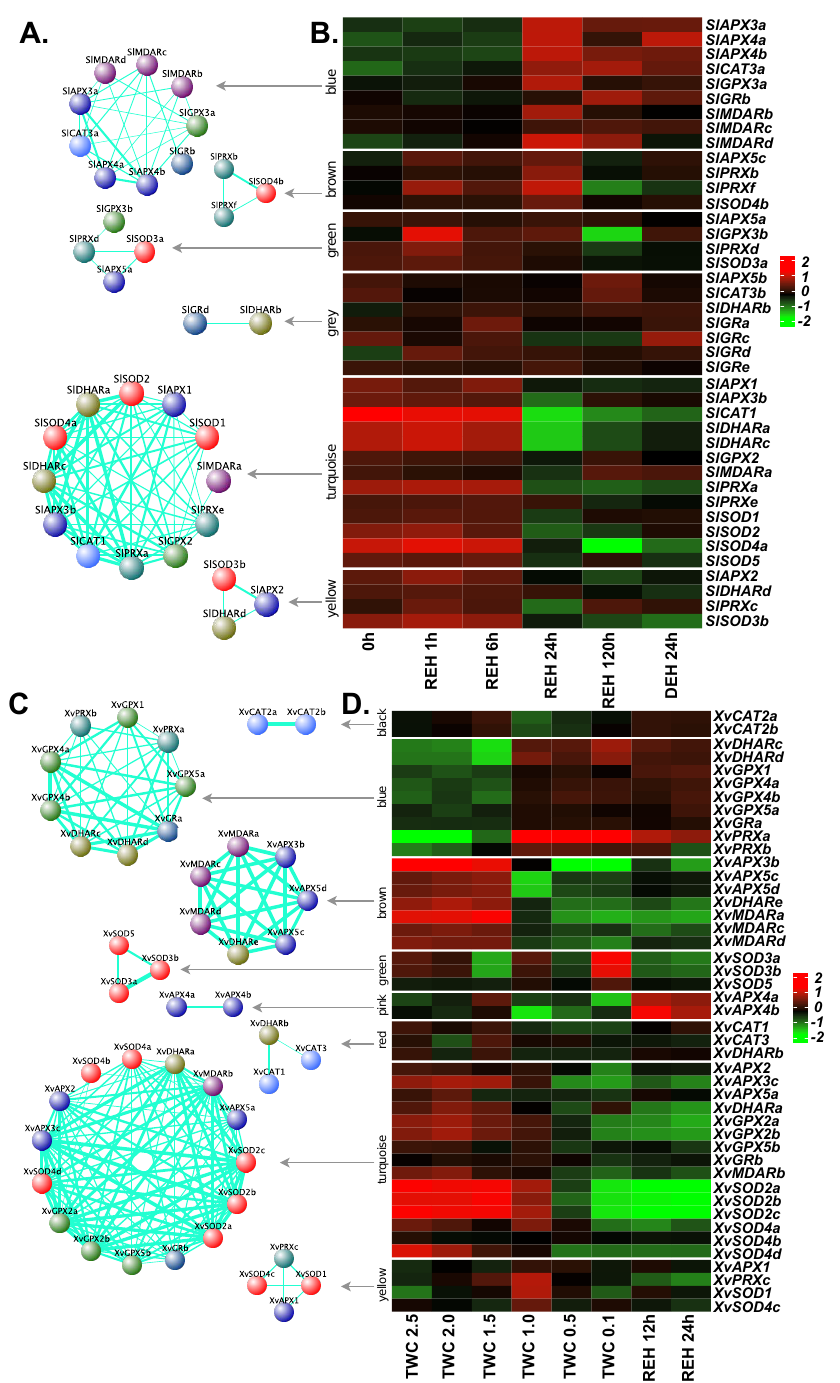
Figure 6. Co-expression network and expression profiles for each module of ROS-related genes in S. lepidophylla and X. viscosa. ( A , B ) S. lepidophylla . ( C , D ) X. viscosa . ( A , C ) Each module is represented as a co-expression network obtained from WGCNA analysis. Nodes correspond to a gene and are colored based on the gene family. Thickness of the edges represent the weight. Edges below adjacency threshold of 0.02 and the nodes without edges were removed. ( B , D ) Expression profile for all the genes in the module are plotted as a heatmap. Color scale represents the log 2 transformed and mean centered TMM values. 0h: three years after desiccation; REH: hours after rehydration; DEH: hours after dehydration post-rehydration; TWC: turgid water content. TWC is the ratio of (fresh weight – dry weight) to dry